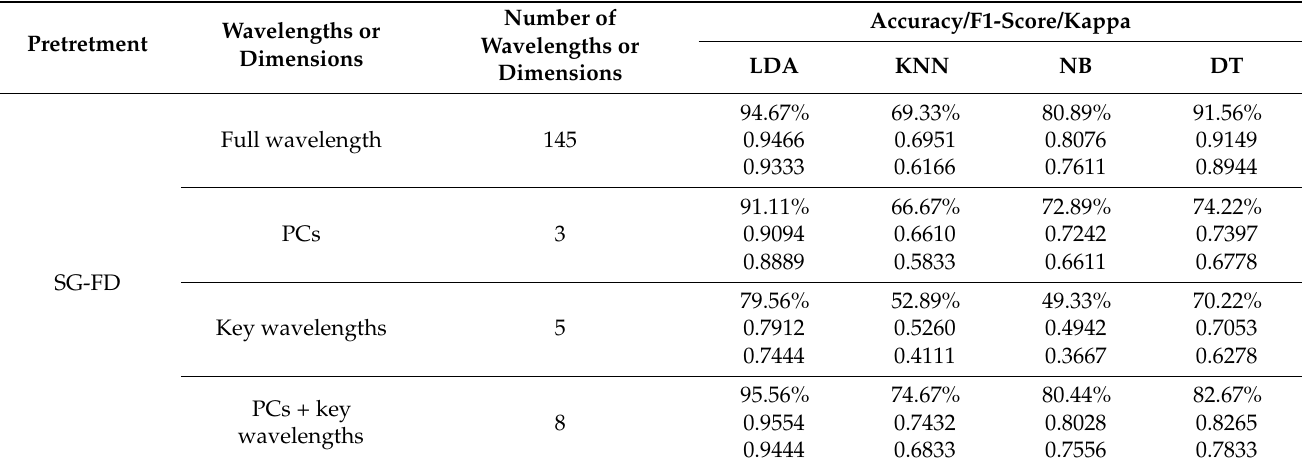
Table 4. Discrimination results of different classification models.